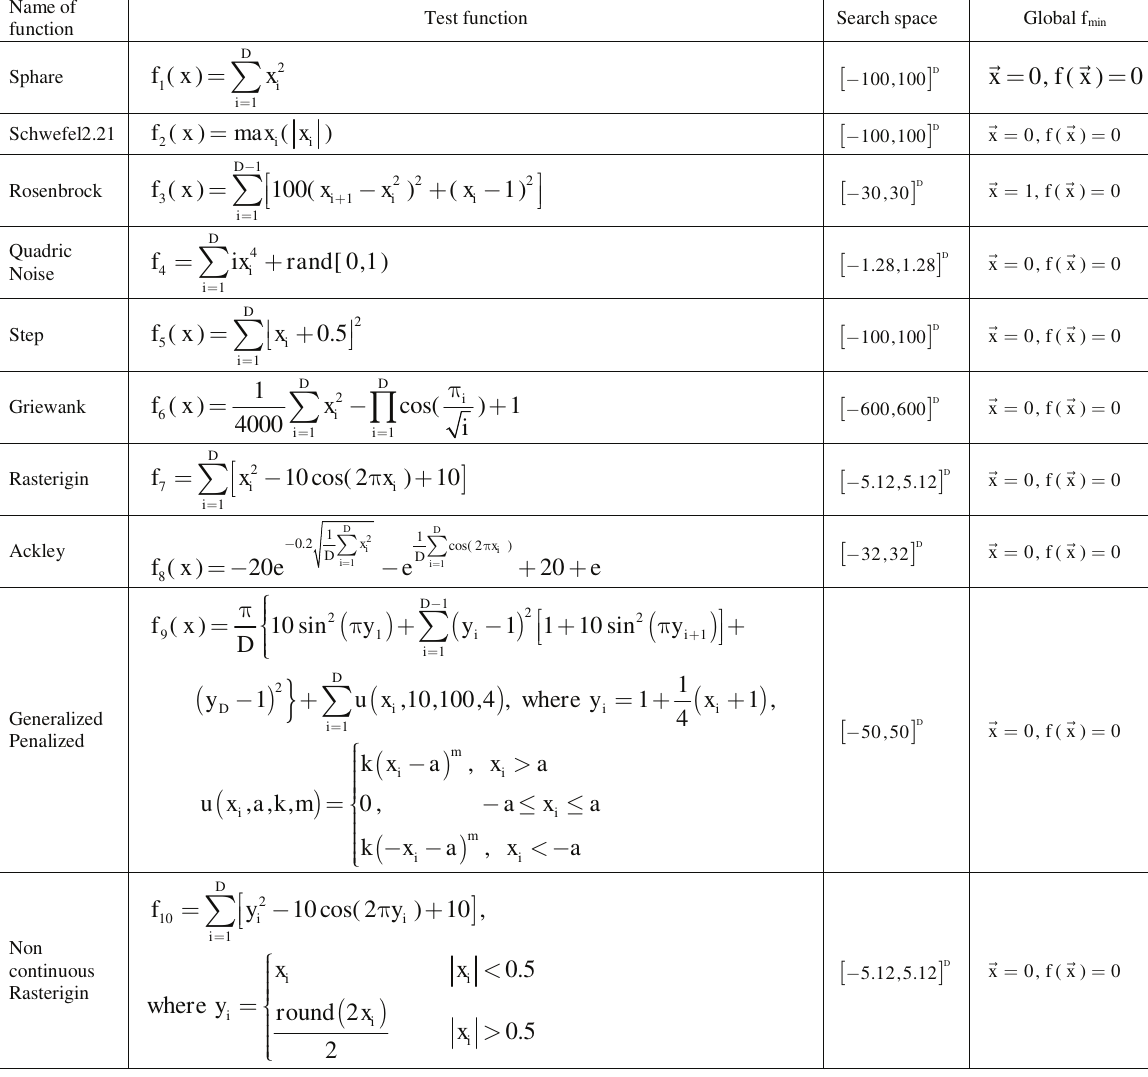
Table 1. Ten Benchmark functions are used in this paper. The first five functions are unimodal and the remaining are